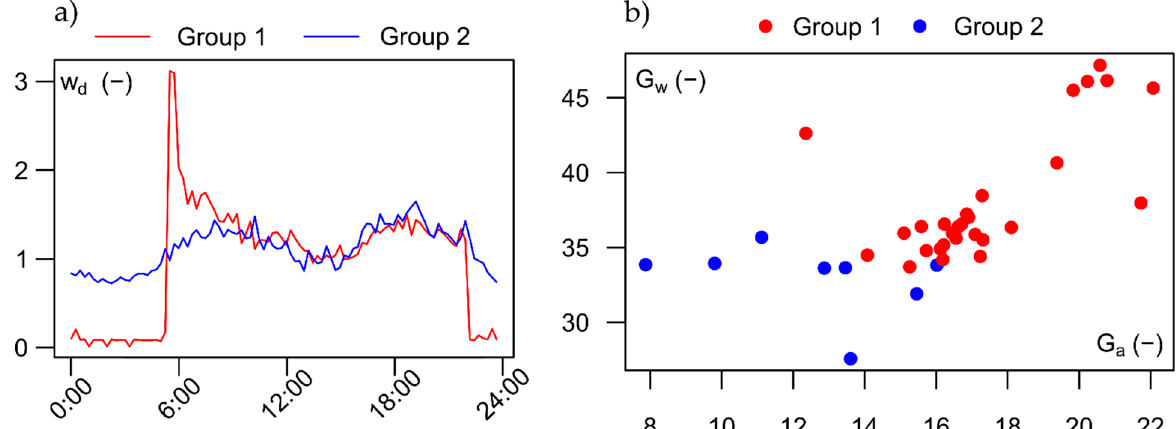
Figure 2. Map of the selected sample of residential users fed by the DH of Bozen-Bolzano in ( a ), and map of the load-based user groups in ( b ).